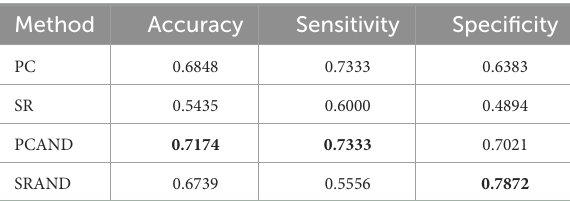
TABLE 2 Classification performance corresponding to different FBN estimation methods on ABIDE